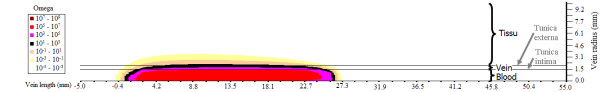
Isodamage distribution inside tissues : power: 15 W, pull-back speed: 1.5 mm/s, vein diameter: 3 mm, λ = 980 nm).